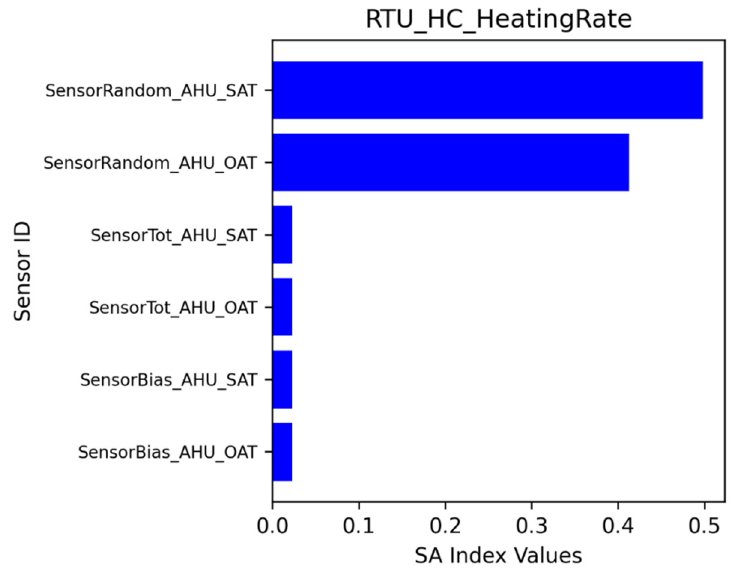
Figure 19. SA for RTU main heating coil heating rate.